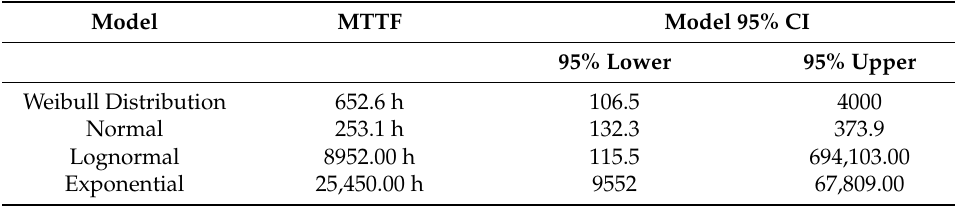
Table 2. MTTF obtained from different statistical reliability models.